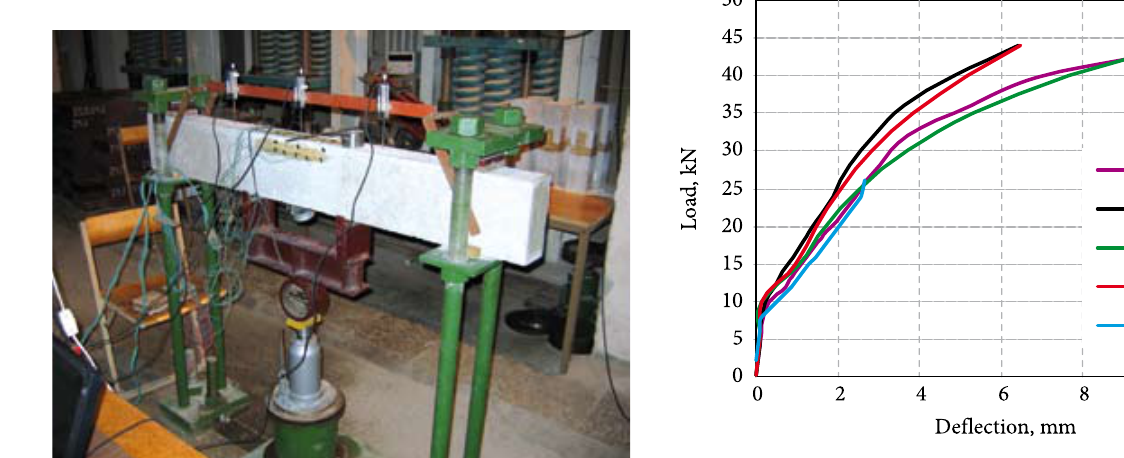
Fig. 7. Experimental (SB6) and theoretical (TSB6) deflections of beams and experimental deflection of control beam